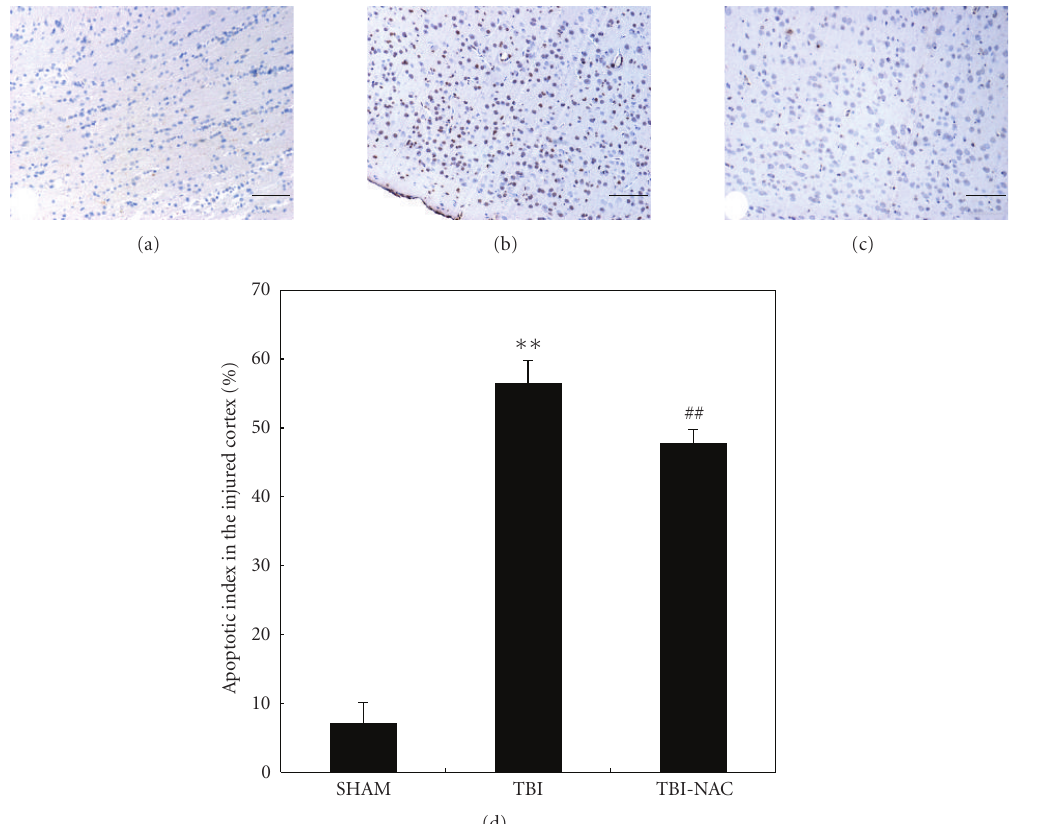
Figure 7: TUNEL immunohistochemistry staining of the injured cortex in SHAM group ( n = 5), TBI group ( n = 6), and TBI-NAC group ( n = 6). (a) SHAM group rats showing few TUNEL apoptotic cells. (b) TBI group rats showing more TUNEL apoptotic cells stained as brown. (c) TBI-NAC group rats showing less TUNEL apoptotic cells than TBI group (scar bar, 50 μ m). (d) Administration of NAC significantly decreased the apoptotic index in rat injured brain following TBI. ∗∗ P < . 01 versus SHAM group; ## P < . 01 versus TBI